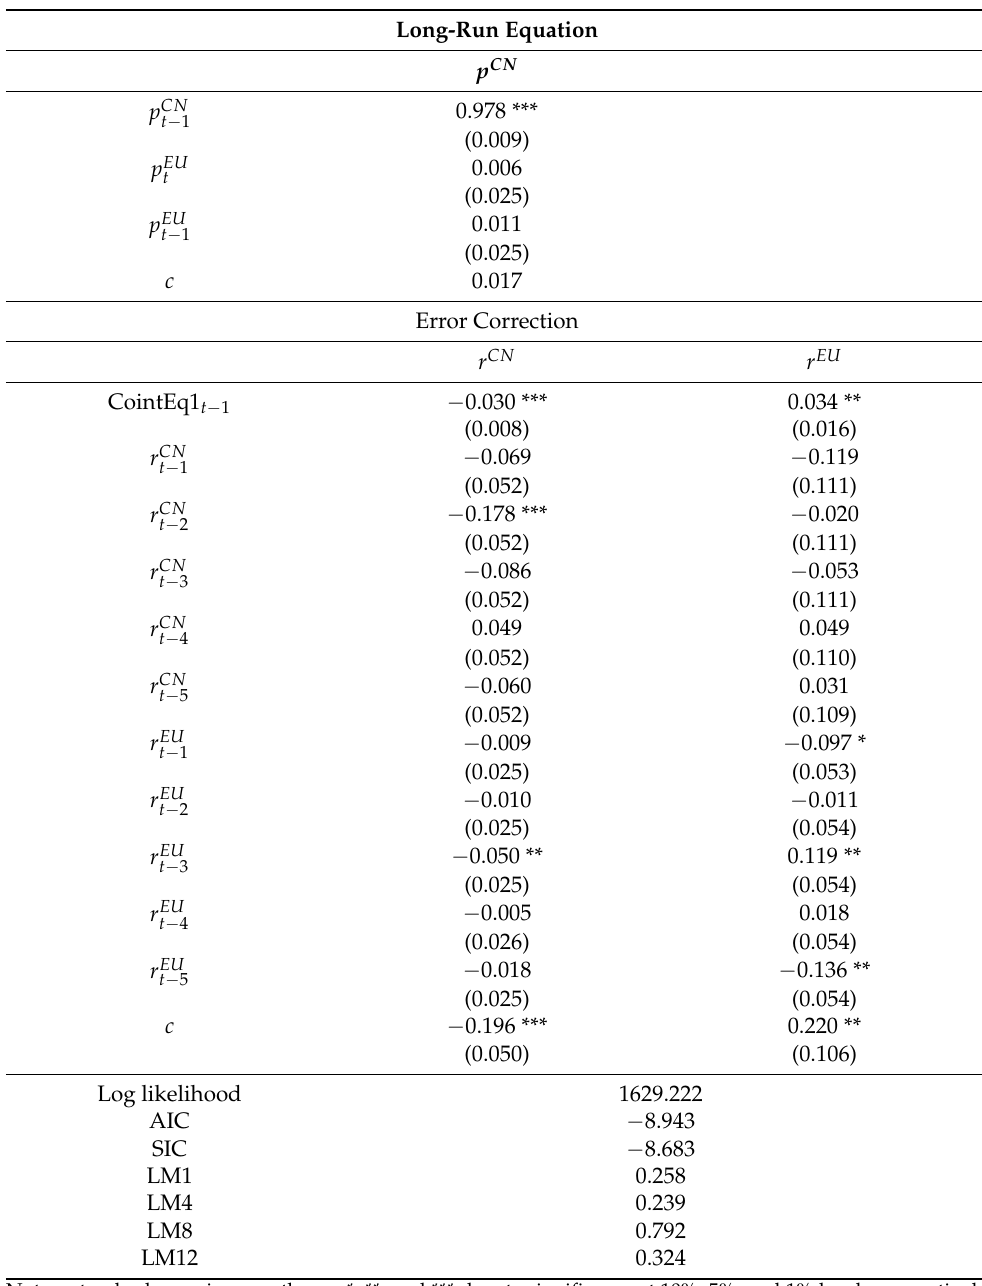
Table 5. VECM estimation result using the dynamic Engle–Granger two-step